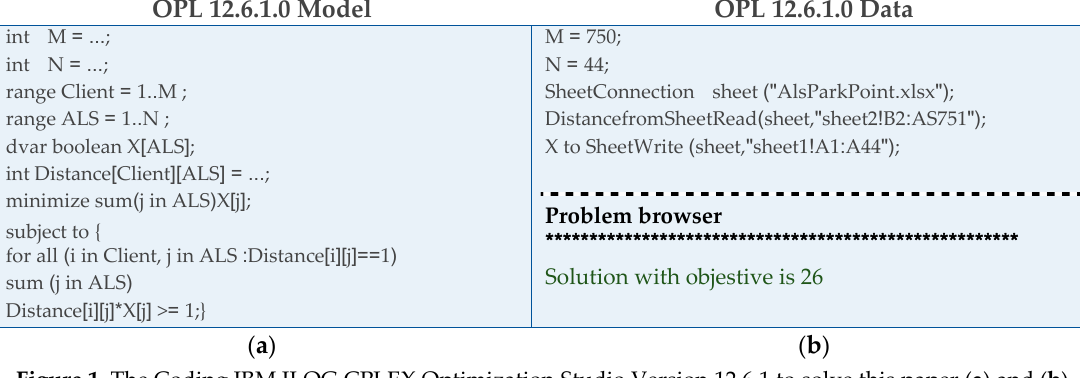
Figure 1. The Coding IBM ILOG CPLEX Optimization Studio Version 12.6.1 to solve this paper ( a ) and ( b ). Table 2. The solution of parking locations covers service areas within the time window